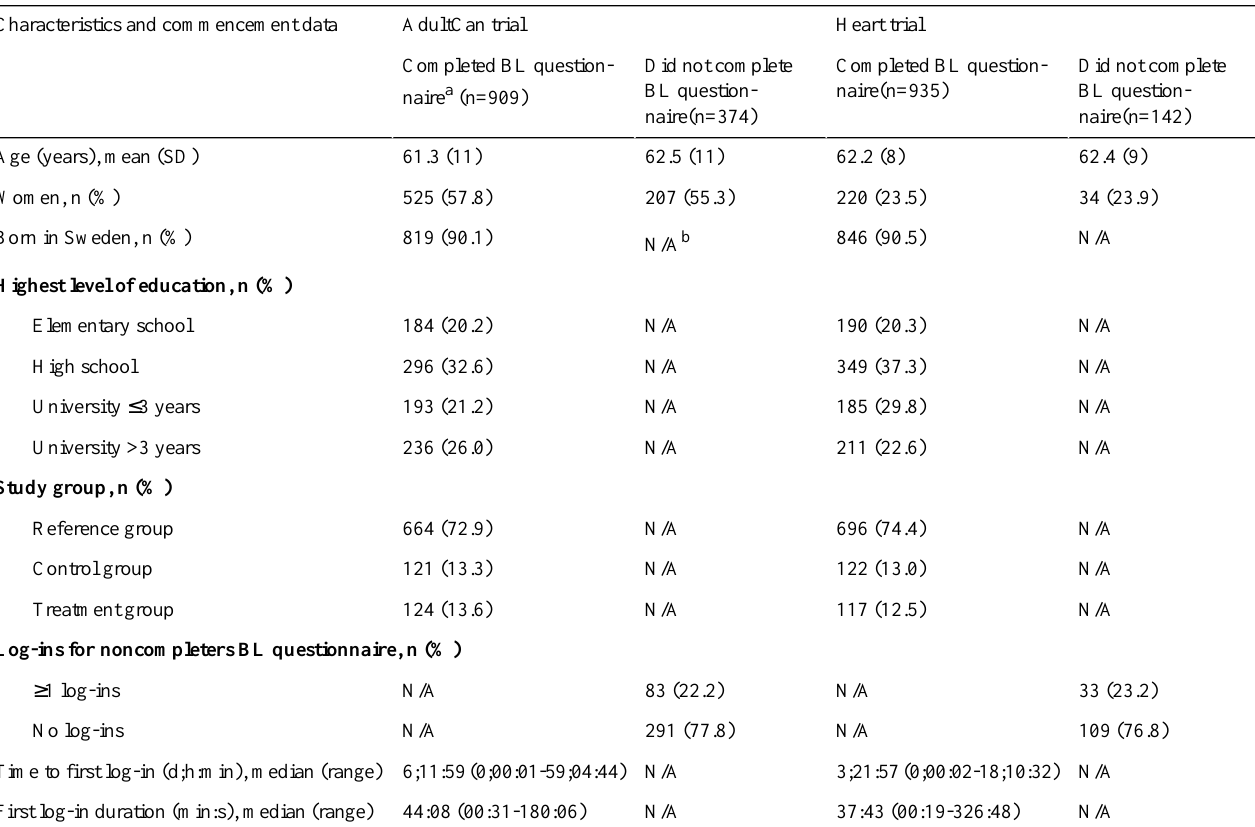
Table 3. Characteristics and commencement data of participants.